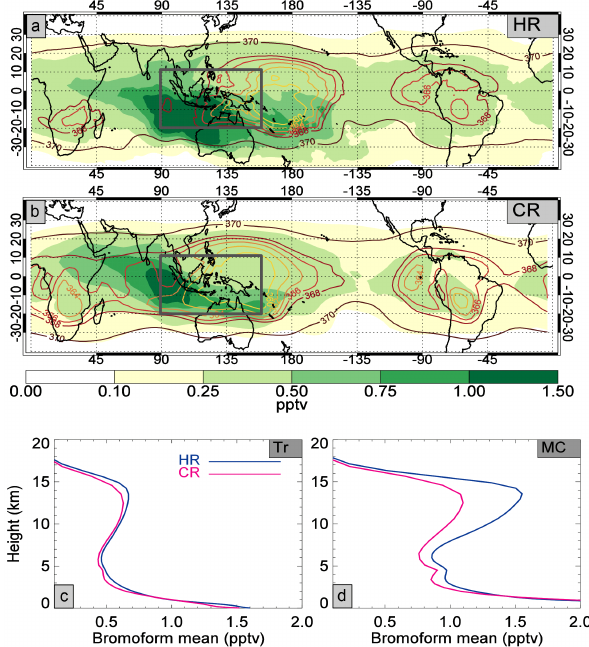
Figure 5. As for Fig. 4, except that these plots are for the Coastal